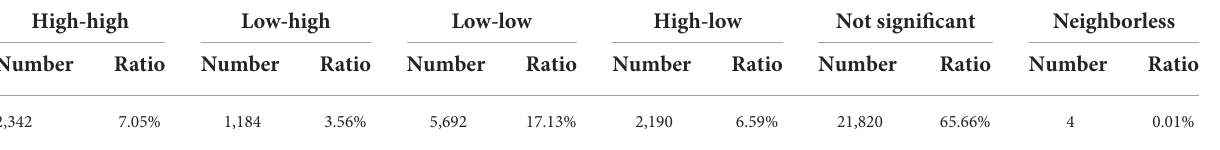
TABLE 6 Quadrants distribution statistics of land patch carbon emissions in Zhangdian.